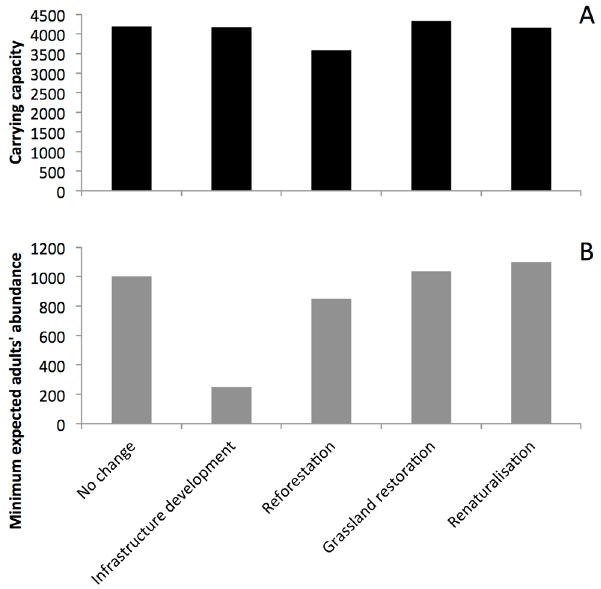
Figure 2. Scenario ranking. (A) Estimated metapopulation carrying capacities of adult individuals for all management scenarios. Estima- tions were based on habitat suitability and population density. (B) Metapopulation dynamics-based estimations of minimum expected adults’ abundances for all scenarios.